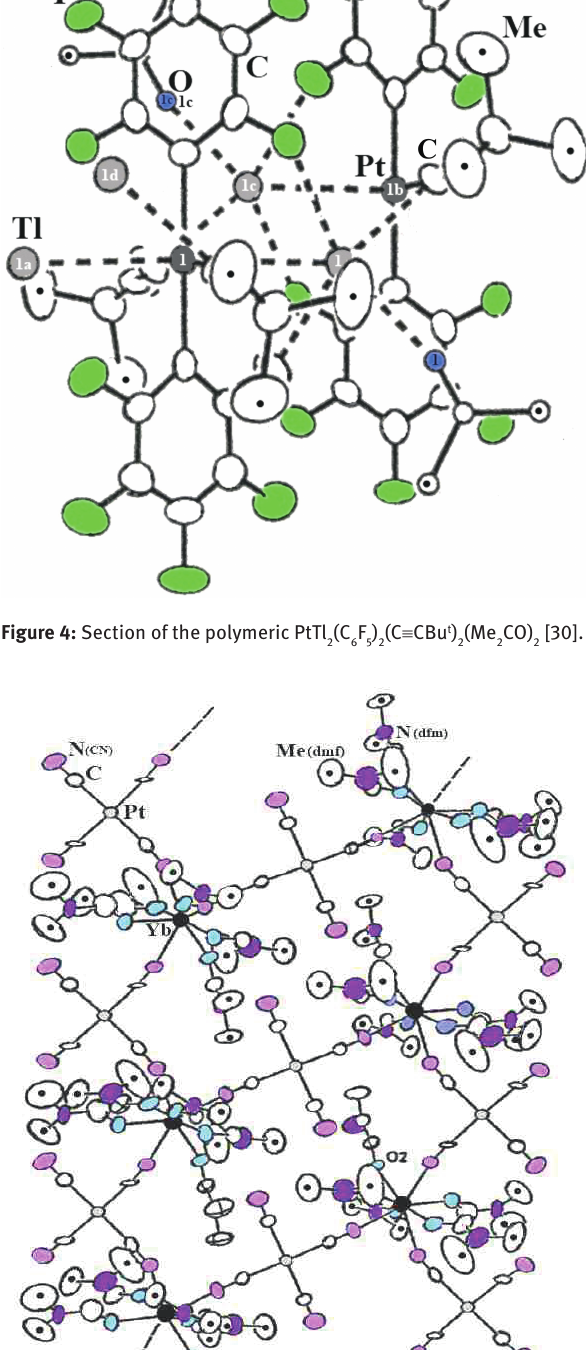
Yb Pt(CN) ] 10 2 4 2